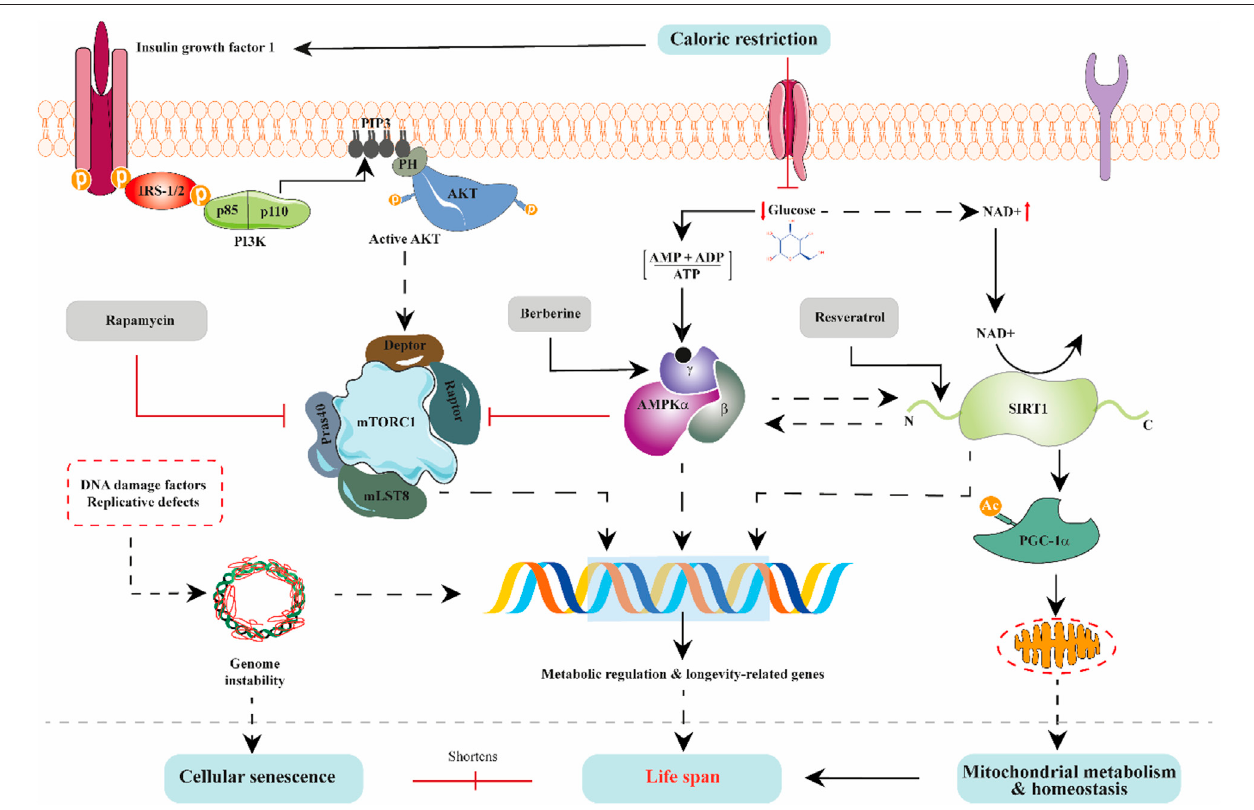
FIGURE3| Theinterlinkedregulationofnutrient-sensingpathways.TheIGF1,mTORC1,AMPK,andSIRT1signalingpathwaysmodulateaging via interactingwith one another. Nutrient availability exerts diverse interrelated in fl uences on these pathways. For instance, decreased intracellular glucose stimulates AMPK and promotes NAD + levels, culminating ininhibition ofmTORC1 activity and enhancement of SIRT1 activity. Suppression ofmTORC1 activity is projected tobe bene fi cialin extending life because inhibition tilts the balance towards mTORC2, enhancing critical age-dependent proteins needed for metabolic regulation. Also, IGF1 signaling activation is known to lower lifespan through mTORC1; however, under caloric restriction conditions, AMPK inhibits mTORC1. Thus, extending life. On the other hand, SIRT1 activation, directly by AMPK or indirectly by NAD + under nutrient restriction, promotes mitochondrial metabolism and homeostasis via PGC1 α . Stabilization of mitochondrial metabolism and homeostasis is known to prolong lifespan. Conversely, in cells, DNA instability resulting from replicative defects and damage to DNA can disorient transcription of metabolic and longevity-related genes and trigger cellular senescence, thus shortening lifespan. In natural product therapeutic pharmacology, rapamycin inhibits mTORC1 activity while berberine and resveratrol activate AMPK and SIRT1 activity,